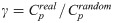
Small-world properties of the metabolic networks.Above graphs indicate the changes in the Gamma γ=Cpreal/Cprandom and Lambda λ=Lpreal/Lprandom in APOE ε4 carriers and APOE ε4 noncarriers (sparsity ranging from 7% to 26%).